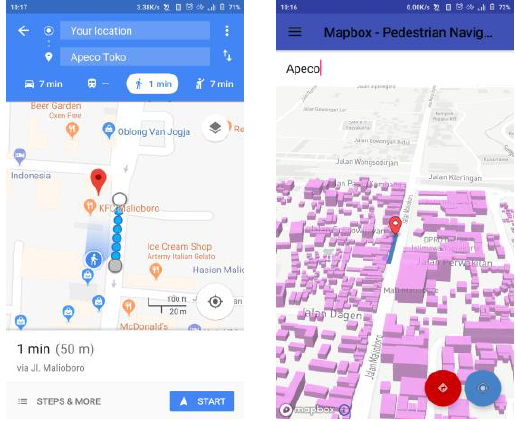
Figure 3. Routing information with 2D map display (left) and with 3D map display in the pedestrian navigation app